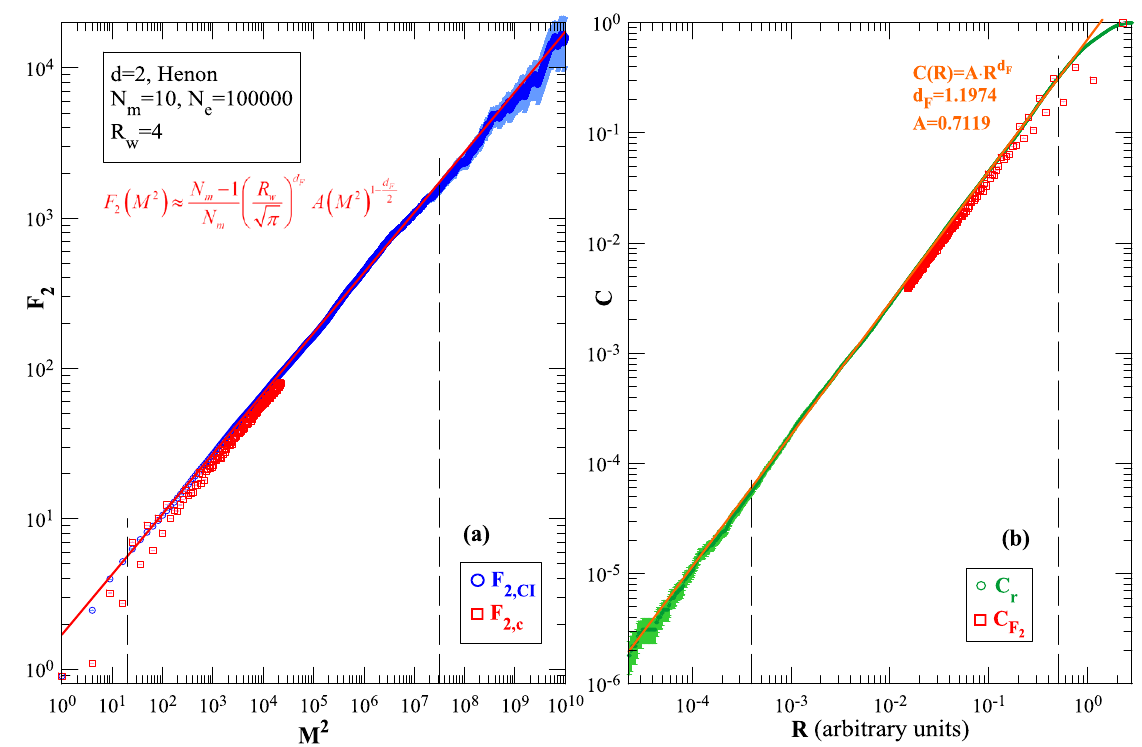
Fig. 8 Analysis of a Henon data set of N e = 100 , 000 events and multiplicity N m = 10 in an embedding space of d = 2 dimensions